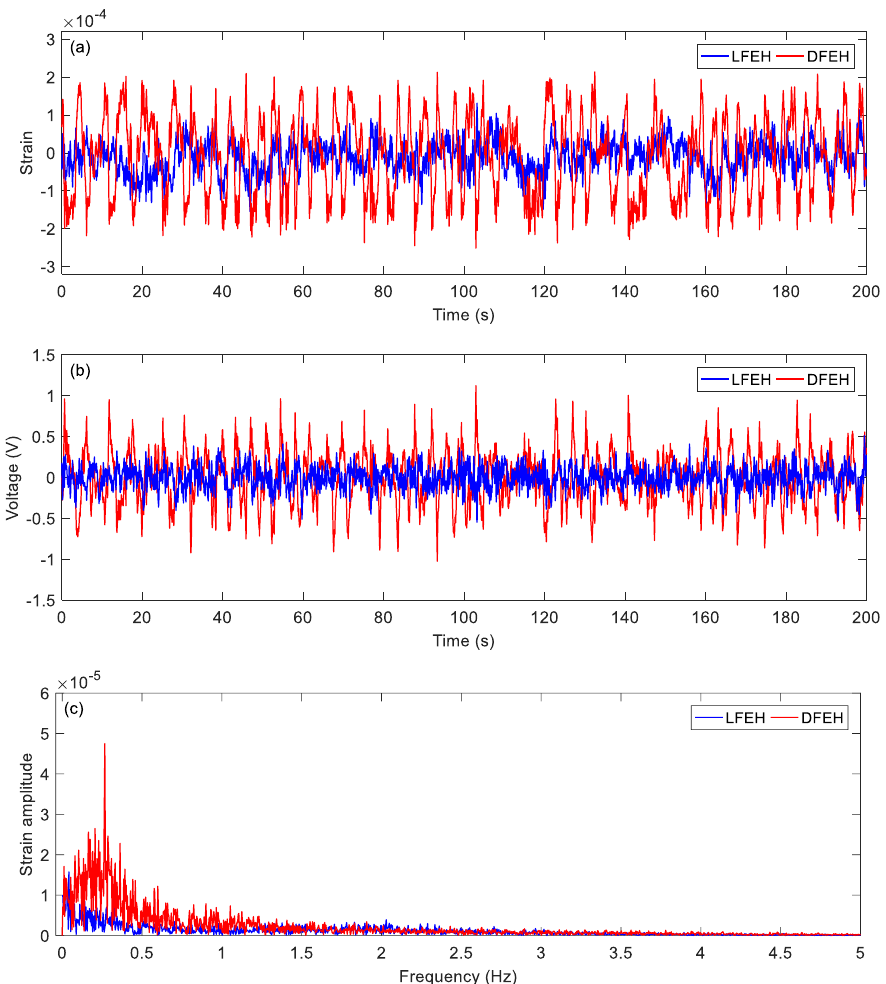
Figure 15. ( a ) Time histories of strain response, ( b ) time histories of voltage response, ( c ) spectrum of dynamic strain response ( v = 5.0 m/s).